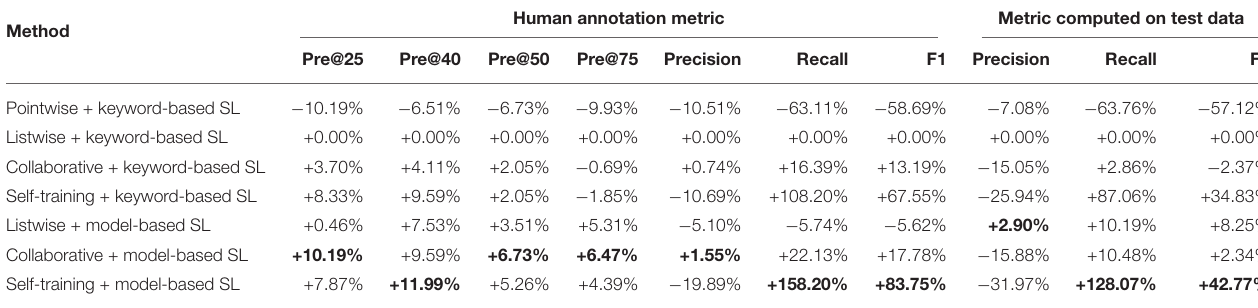
Human annotation metric